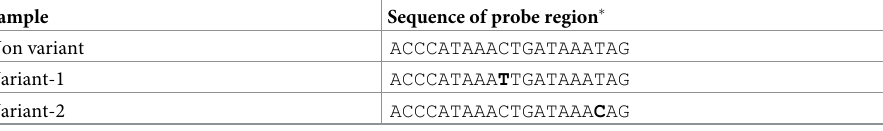
Table 1. Probe region sequences.